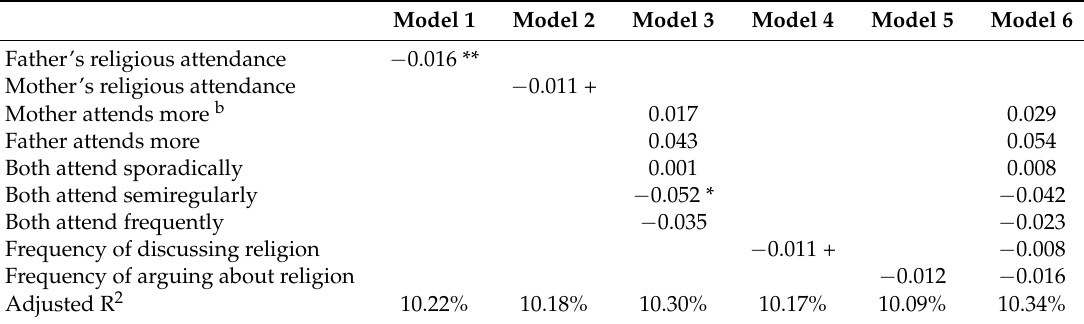
Table 3. Unstandardized coefficients predicting children’s internalizing problem behaviors (teachers’ ratings, n = 10,720) a